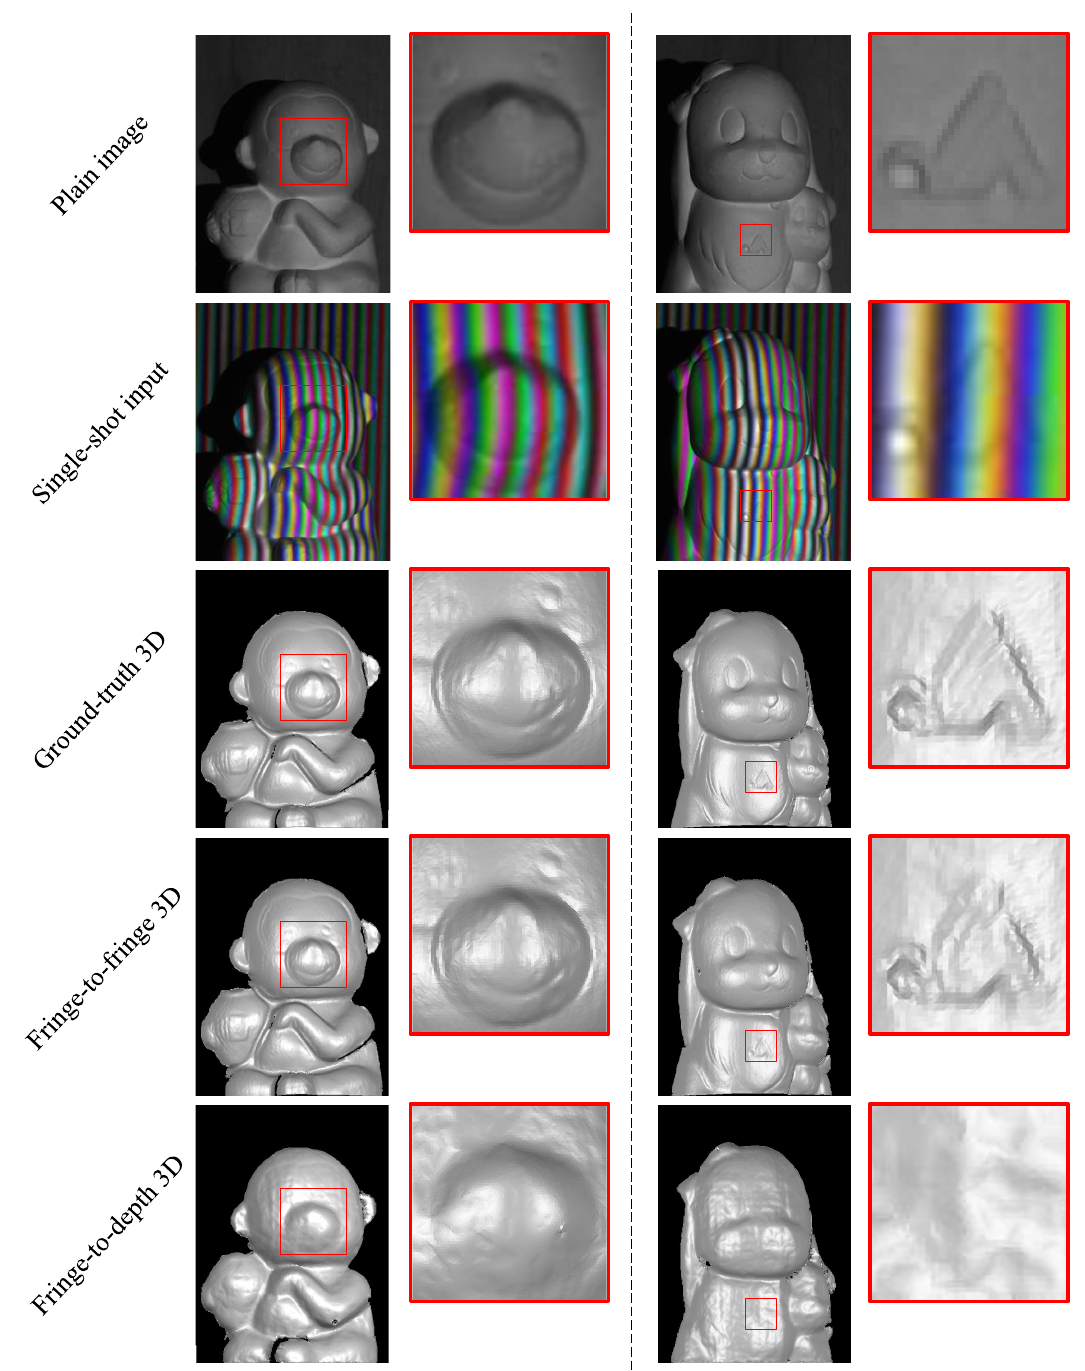
Figure 4. 3D shape reconstruction of the proposed technique and the comparative fringe-to-depth